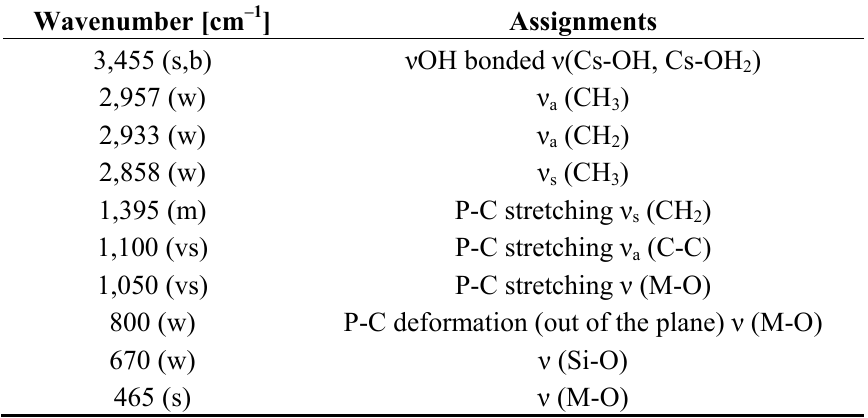
Table 1. Assignments of the IR vibrations of the studied material